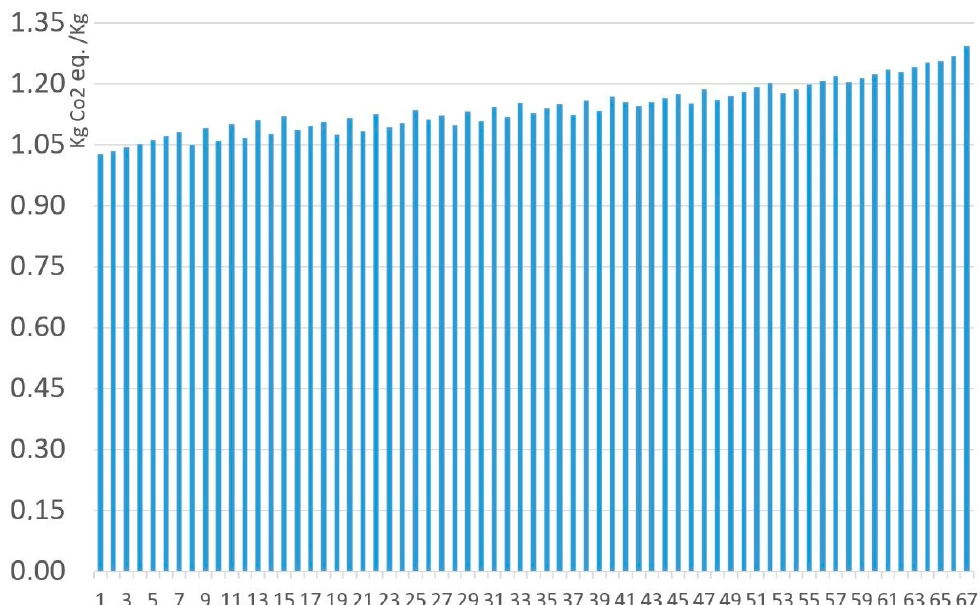
Figure 8. Environmental impact (RMA + Production) of 1 kg MnZn for the 67 ferrites, under the Carbon Footprint methodology.